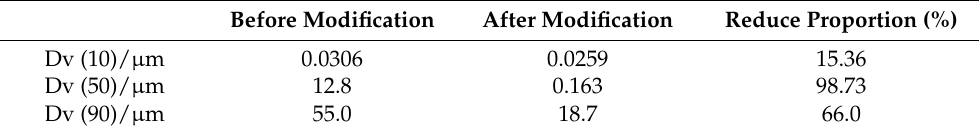
Table 2. Changes in particle size and volume of spent FCC catalyst before and after modification.